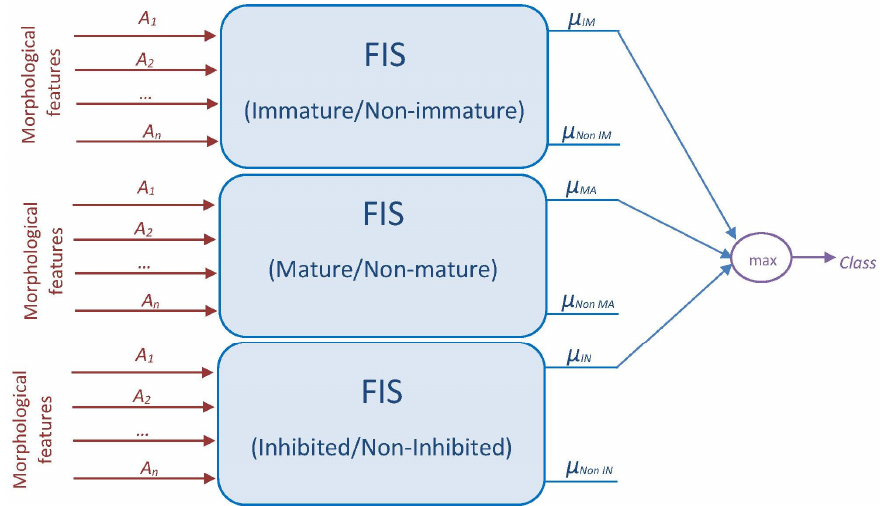
Figure 5. Flowchart of the proposed FIS1 system for fuzzy DCs classification.